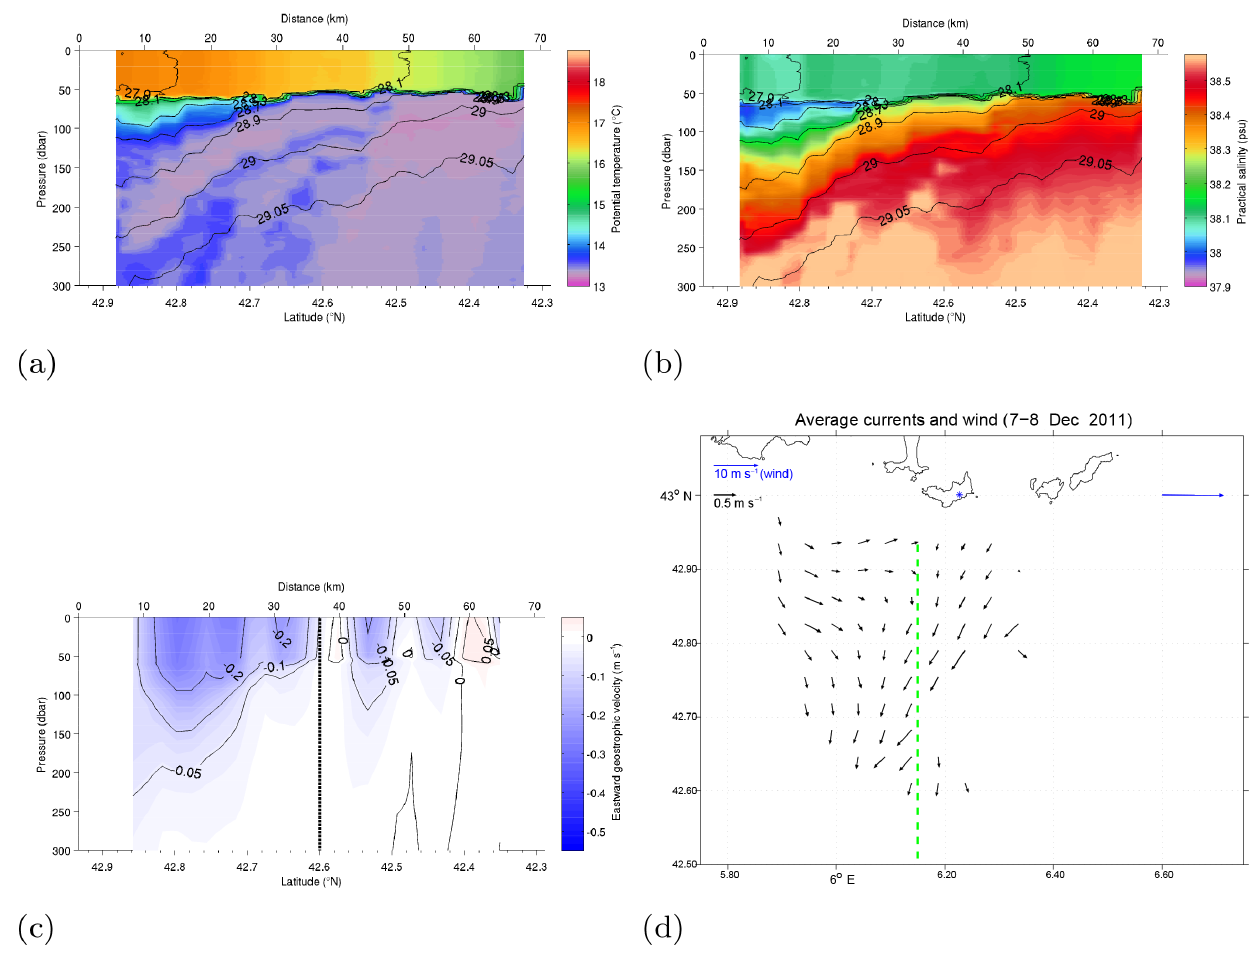
Figure 4. Potential temperature (a) , salinity (b) , and geostrophic velocity (c) for glider Transect 3 (see also Table 1 for time period definition). Potential density anomaly isolines (black) are in panels (a) and (b) . The black dashed line (c) represents the southern boundary of the HF radar field. In panel (d) , black arrows show the surface currents from HFR averaged during the period in which the glider transect (green dashed line) falls inside the HFR coverage (and considering only grid points with at least 80% available data over the time period). The blue arrow represents the wind from Porquerolles station averaged over the same period considered for the HFR